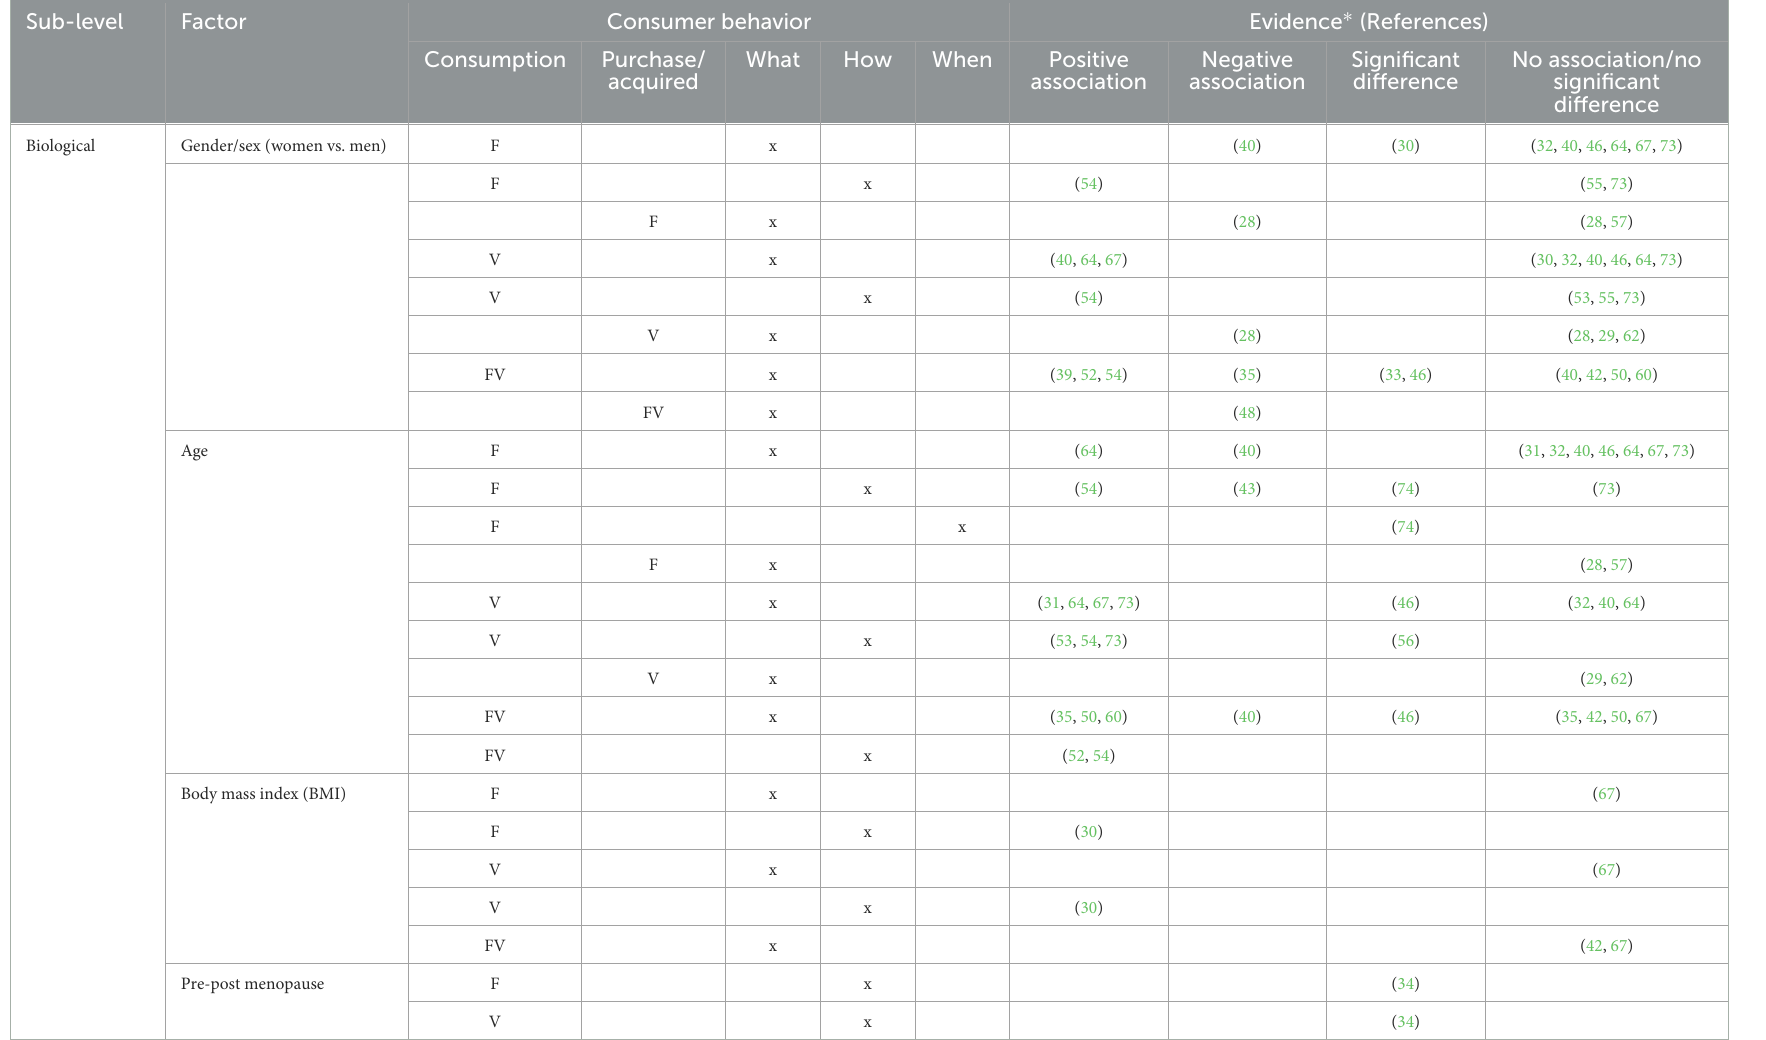
TABLE 2A Individual/household level